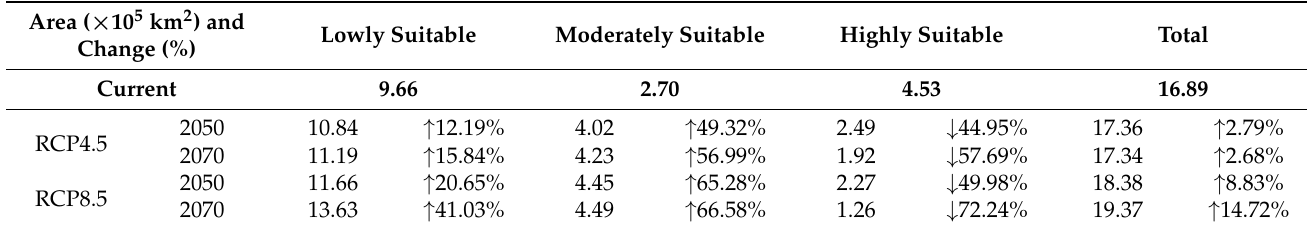
Table 4. Different classes of potential suitable regions and their percentage change compared to current Cypripedium japonicum under current and four future climate scenarios. Up arrow ( ↑ ) means increase, down arrow ( ↓ ) means decrease. Area ( × 10 5 km 2 ) and